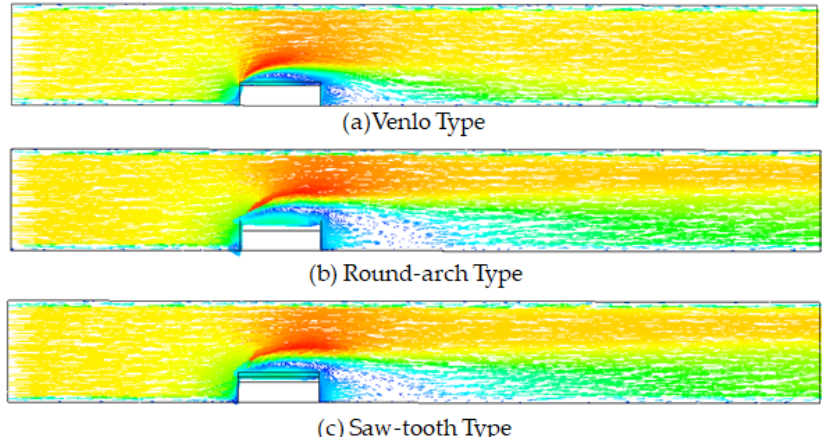
Figure 2. Velocity vector over three types of greenhouses. Table 2. Greenhouse grid quality evaluation factors .